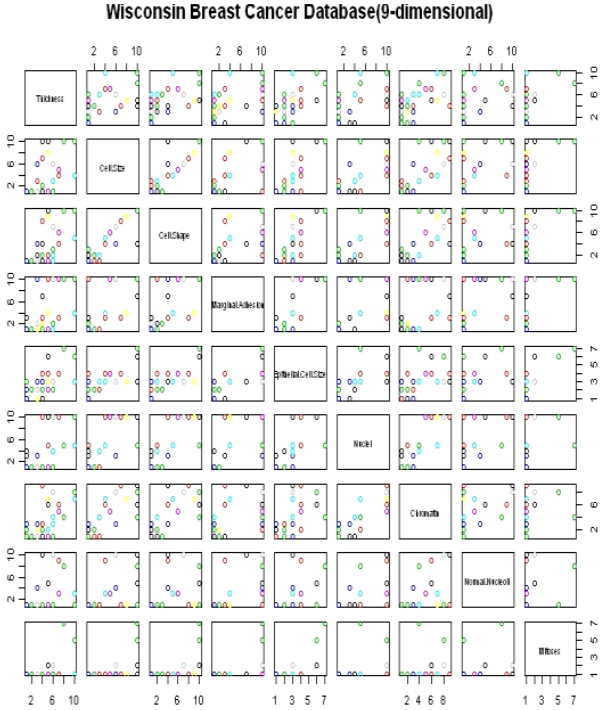
Fig. 21. 699 Breast Cancer Dataset.